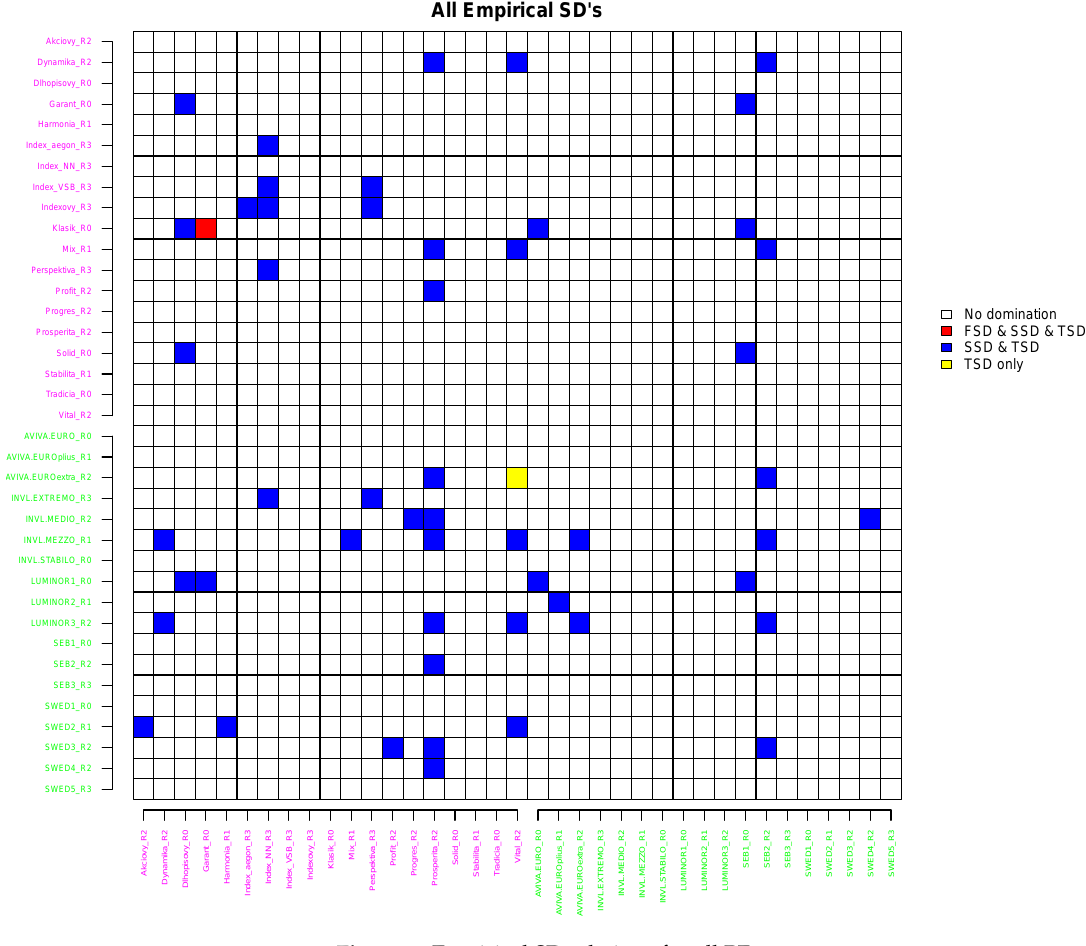
Figure 7. Empirical SD relations for all